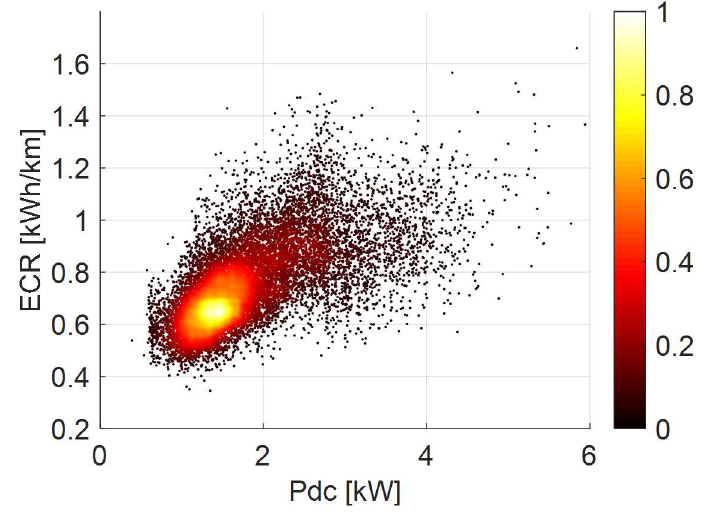
Figure 7. The relation between the DC converter power and ECR.